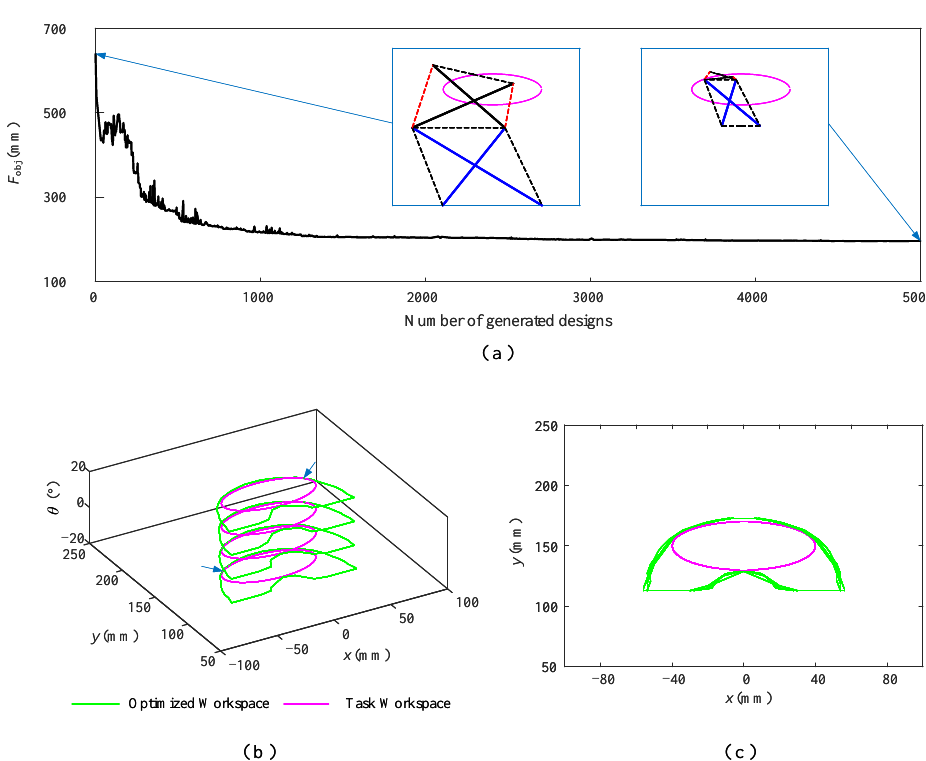
Figure 12. Workspace of the optimized configuration and task workspace (Example 2). ( a ) Optimiza- tion history. ( b ) Isometric view. ( c ) Top